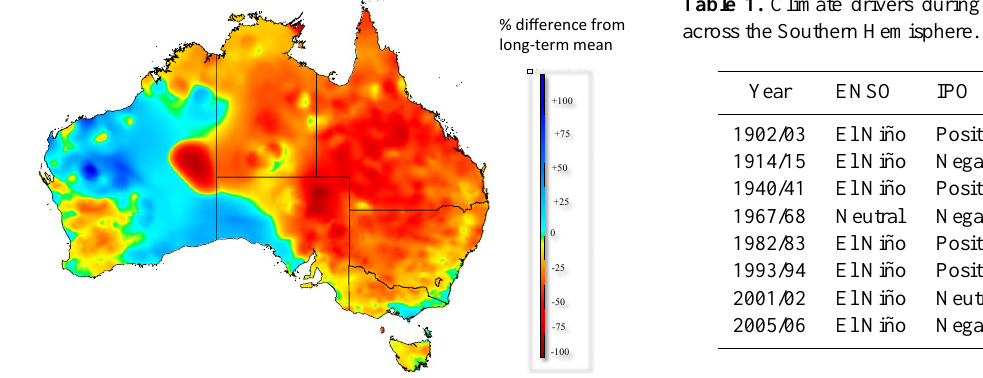
Figure 4. Spatial extent (in terms of rainfall anomalies) of the Fed- eration Drought ( ∼ 1895–1902) in Australia (from Verdon-Kidd and Kiem 2009).